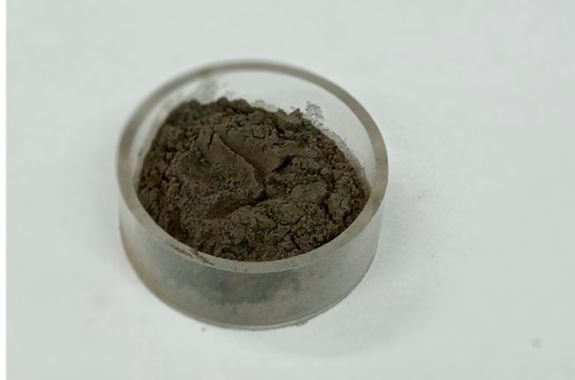
Figure 2. Basalt rock from open-pit mine (photo by K. Se ń czuk).